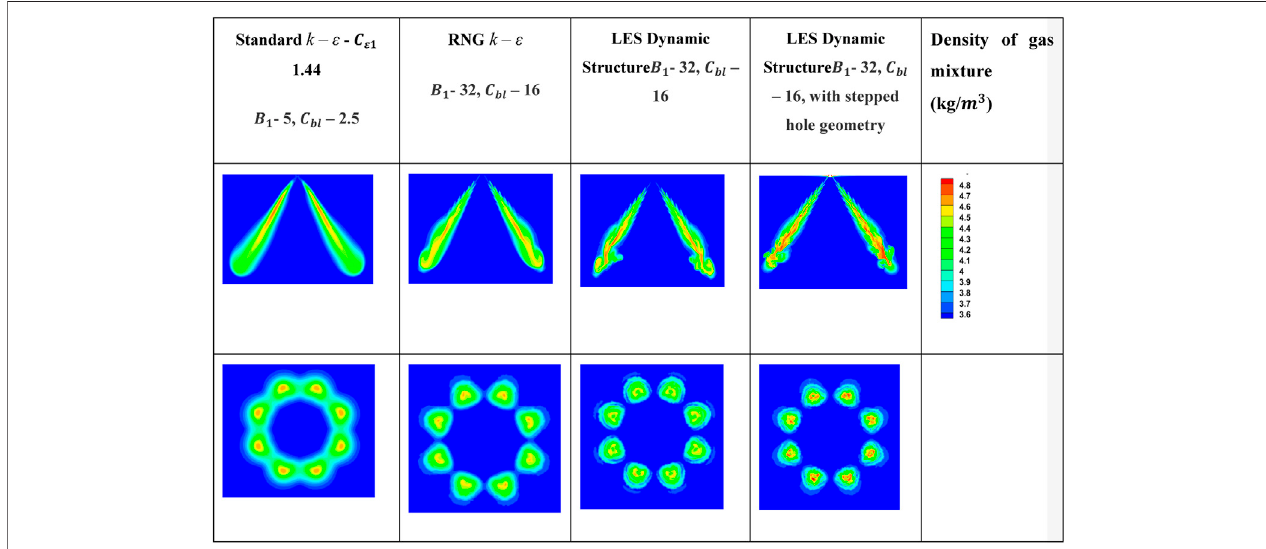
FIGURE12| Comparison ofthepredictions ofdensity variations at0.8 msusing threedifferent modelingapproachesforSprayGstandard conditions[Standard k – ε turbulence model C ε B C bl =2.5, cone-angle 25 ° ,plumetargetingangle35 ° andall othercases with B 1 -1.44; 1 =5, angle 35 °